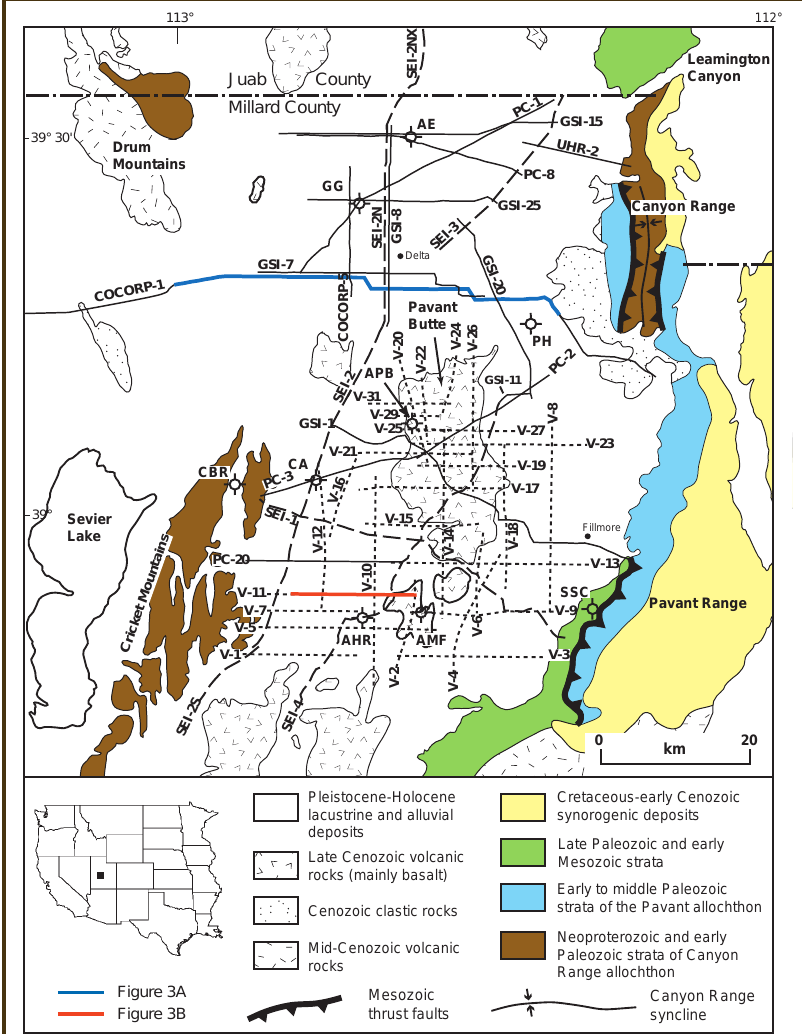
3BFigure 3A Figure Figure 2. Generalized map of the Sevier Desert basin, west-central Utah, showing locations of wells and seismic reflection profiles (from Wills et al., 2005; see Fig. 1 for location). Wells: AE, Argonaut Energy Federal; AHR, ARCO Hole-in-Rock; AMF, ARCO Meadow Federal; APB, ARCO Pavant Butte; CA, Cominco American Federal; CBR, Chevron Black Rock; GG, Gulf Gronning; PH, Placid Henley; SSC, Shell Sunset Canyon. Solid, dashed, and dotted lines correspond with different seismic datasets. Part of Consortium for Continental Reflection Profiling (COCORP) Utah Line 1 (blue) is shown in Fig. 3A. A portion of Vastar Resources, Inc. Line V-11 (red) is shown in Fig. 3B. Thrust faults are the tightly folded Canyon Range thrust in the Canyon Range and the structurally lower Pavant thrust in the Pavant Range (teeth on upper plate). Inset map shows location relative to states in the western